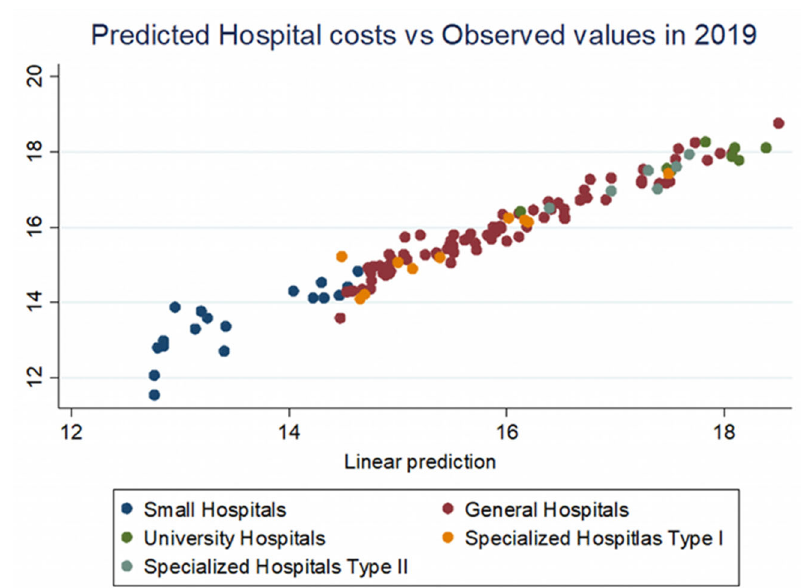
Figure 5. Predicted hospital costs vs. observed values in 2019.